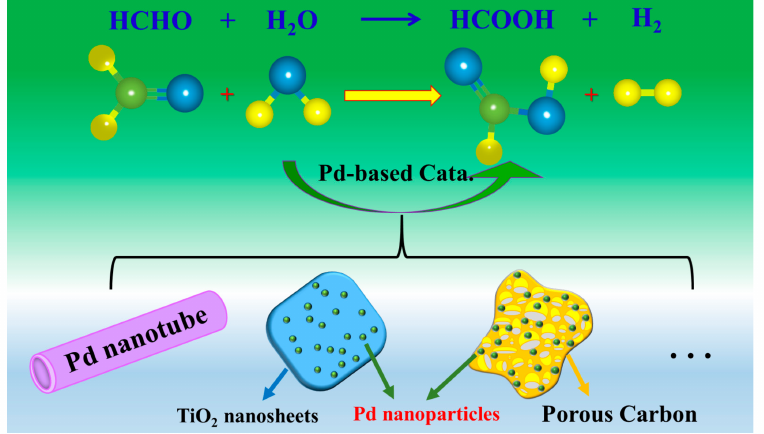
Figure 1. Schematic diagram of Pd-based catalysts’ structure designed to catalyze hydrogen produc- tion from